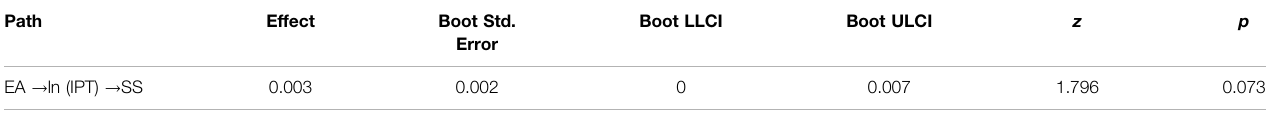
TABLE 9 | Bootstrap sampling test.